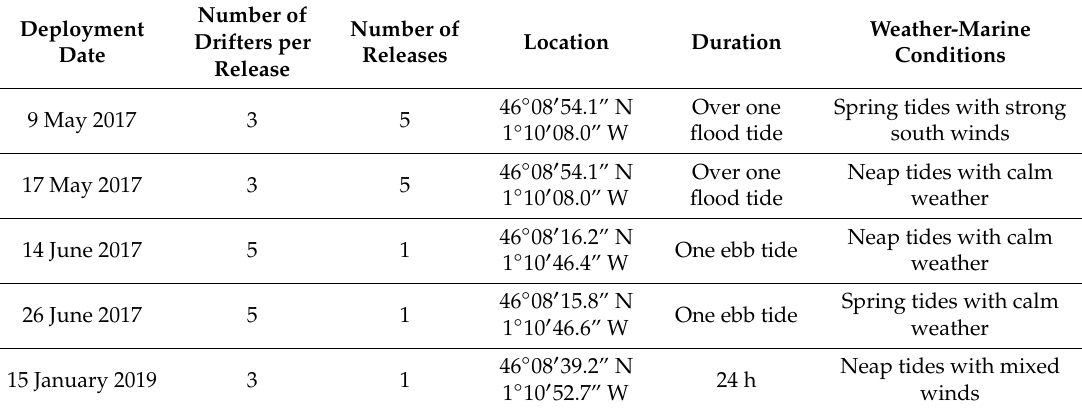
Table 2. The drifting buoys deployments and their corresponding